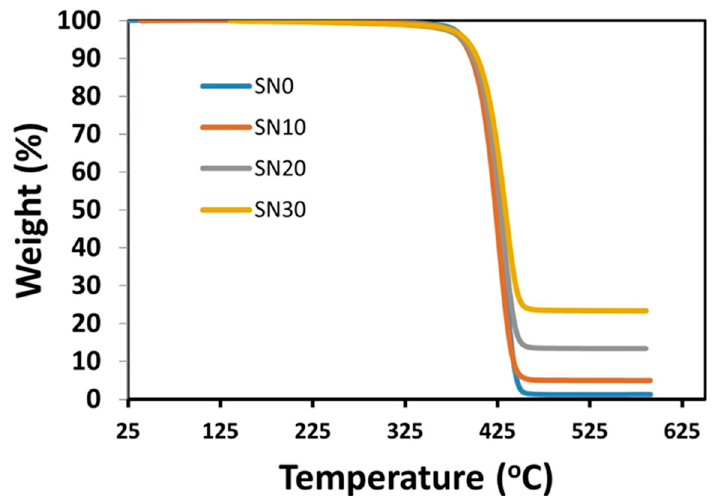
Figure 8. Thermogravimetric curves of pristine PS and PS/m-BN composites.